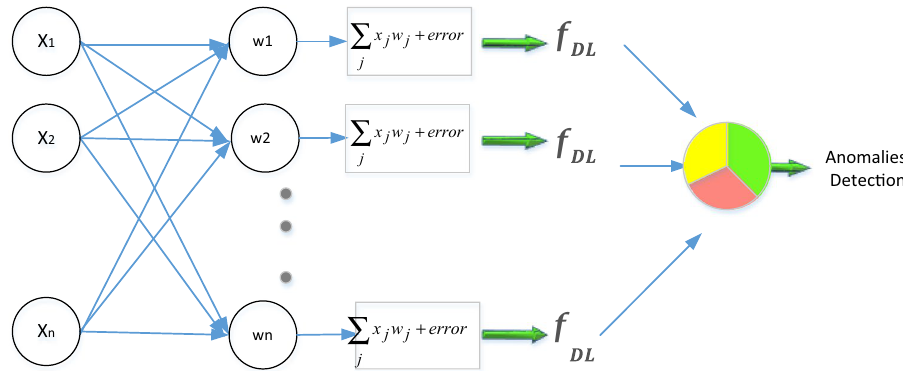
Fig. 10 DL for anomaly detec-